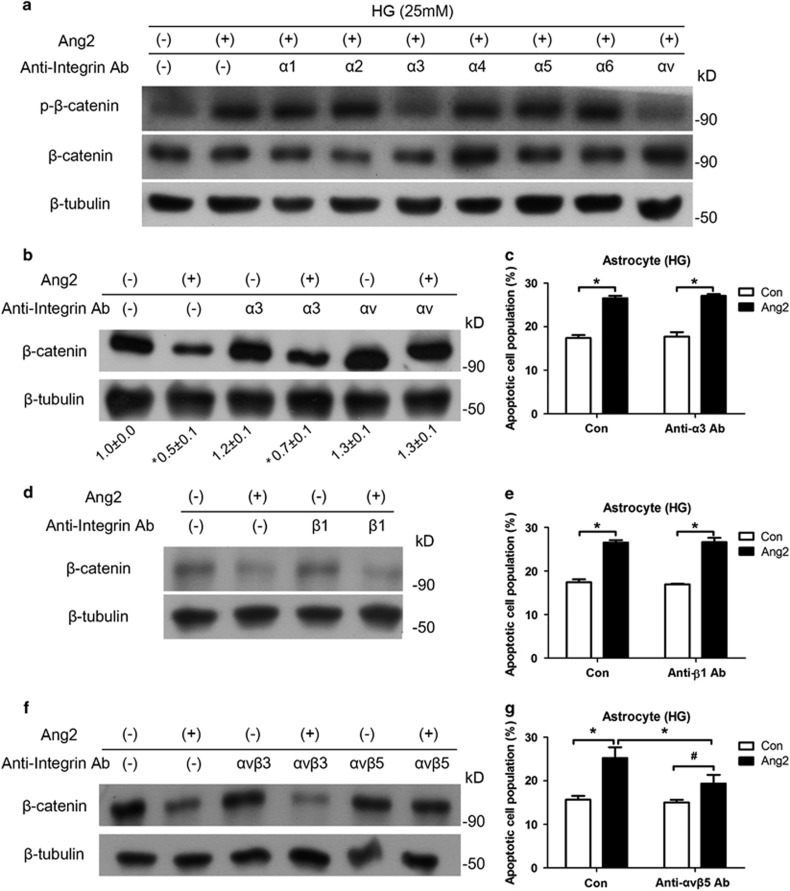
Ang2-induced astrocyte apoptosis is inhibited by suppression of αvβ5 integrin. (a) Western blot analyses for phosphor-β-catenin (Thr41/Ser45) and β-catenin were performed on lysates obtained from astrocytes treated with Ang2 (300 ng/ml) or various integrin-blocking antibodies (10 μg/ml, α1, α2, α3, α4, α5, α6, and αv) under 25 mM high glucose (HG) for 30 min. (b and c) Astrocytes were incubated under HG with Ang2 and anti-integrin α3 or αv antibodies for 48 h. (b) Western blot analysis for β-catenin was performed (ImageJ quantification; N=3, mean±S.E.M.). (c) Astrocyte apoptosis with anti-integrin α3 antibody was analyzed by FACS and expressed as the percentage of apoptotic cells in total cell populations. (d and e) Astrocytes were incubated under HG with Ang2 and anti-integrin β1 antibody (10 μg/ml) for 48 h. (d) Western blot analysis for β-catenin was performed. β-Tubulin was used as a loading control. Data represent three independent experiments. (e) Astrocyte apoptosis with anti-integrin β1 antibody was analyzed by FACS and expressed as the percentage of apoptotic cells in total cell populations. (f and g) Astrocytes were incubated under HG with Ang2 and anti-integrin αvβ3 or αvβ5 antibodies (10 μg/ml) for 48 h. (f) Western blot analysis for β-catenin was performed. β-Tubulin was used as a loading control. Data represent three independent experiments. (g) Astrocyte apoptosis with anti-integrin αvβ5 antibody was analyzed by FACS and expressed as the percentage of apoptotic cells in total cell populations. *P<0.05, #P>0.05 compared with Ang2 treatment by Student's t-test